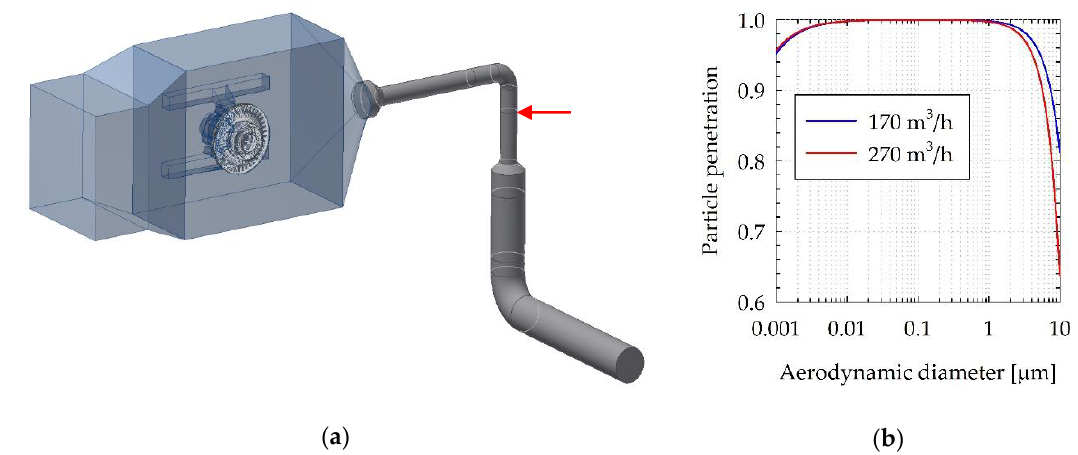
Figure 1. ( a ) Layout of the dilution tunnel with red arrow indicating the location of the sample probes; ( b ) calculated particle penetration in the duct assembly down to the point where the sample probes are installed.